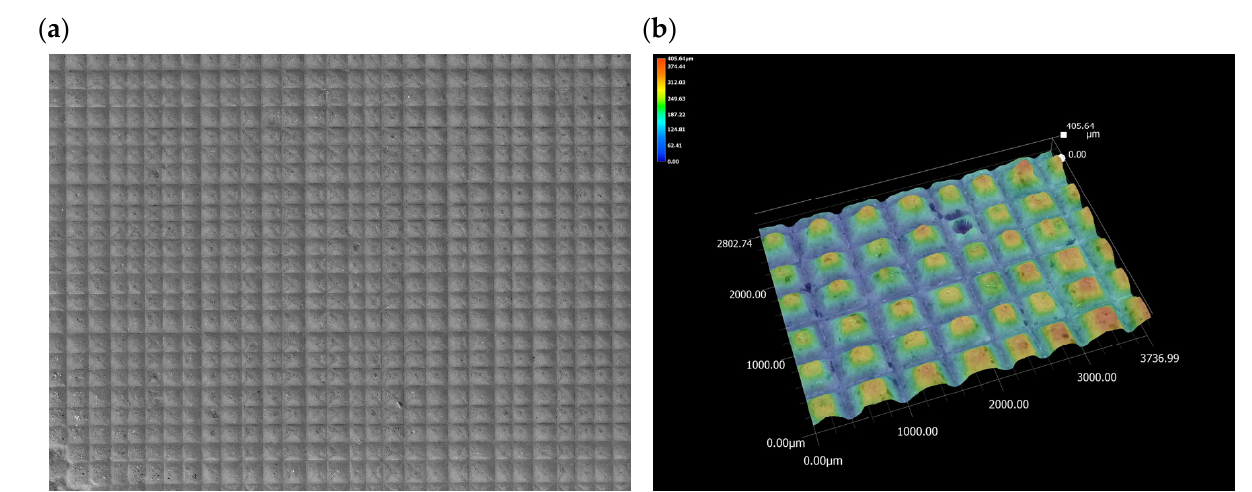
Figure 10. Microscopic view of the active surface of the ceramic grinding wheel: ( a ) 80× magni fi ca- tion view of the grinding wheel; ( b ) 80× magni fi cation analysis of the surface topography of the ceramic grinding wheel.